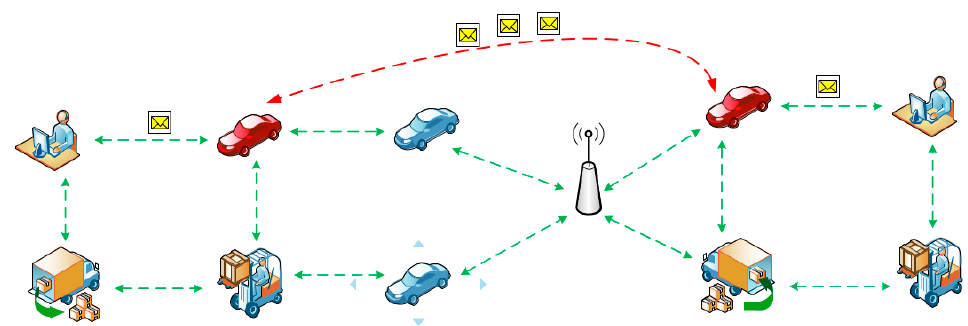
Figure 8. The wormhole attack case.